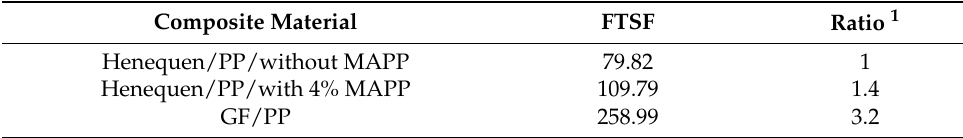
Table 3. Fiber Tensile Strength Factor of PP composites. Composite Material FTSF Ratio 1 Henequen/PP/without MAPP 79.82 Henequen/PP/with 4%